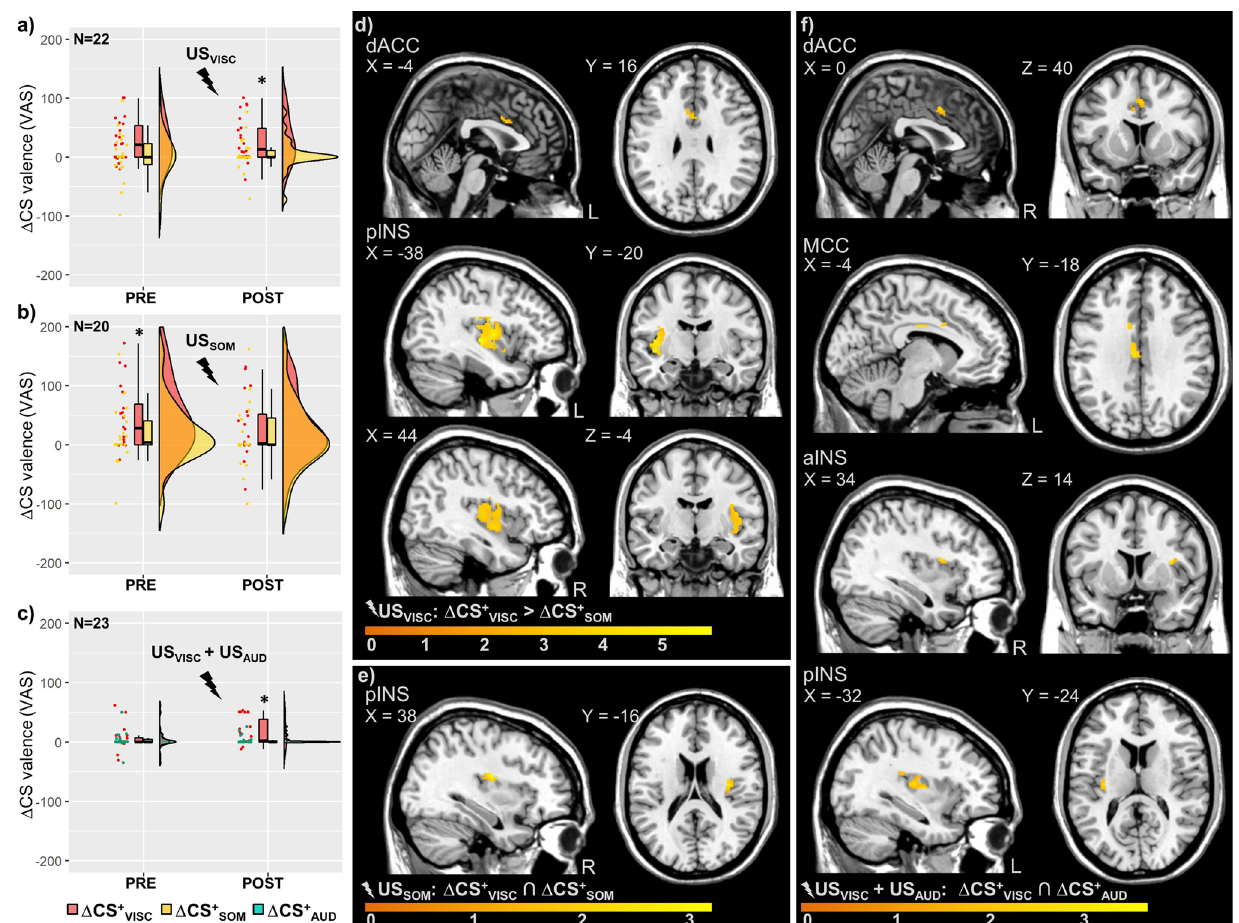
Fig. 3 Behavioural and neural responses to cues (CS) predicting interoceptive versus exteroceptive threats during reinstatement-test in studies 1 and 2. After reinstatement with unexpected US, negative valence was greater for interoceptive compared to exteroceptive threat predictors in reinstatement groups involving US VISC a study 1, US VISC -subgroup, Δ CS + VISC versus Δ CS + SOM ; c study 2, Δ CS + VISC versus Δ CS + AUD ; *both P < 0.05, results of Bonferroni-corrected paired t -tests between modalities, full results in Supplementary Tables S4 – S7, whereas no difference was observed in the US SOM - subgroup b study 1, Δ CS + VISC versus Δ CS + SOM ). Individual delta ( Δ ) scores were computed for differential CS valence of each CS + relative to the CS − . Data are presented as individual data points, boxplots, and densities (raincloud plots 117 ). At the neural level, differential activation induced by interoceptive cues was enhanced in the US VISC -subgroup within dACC and pINS during reinstatement-test d study 1, Δ CS + VISC compared to Δ CS + SOM, all P FWE <